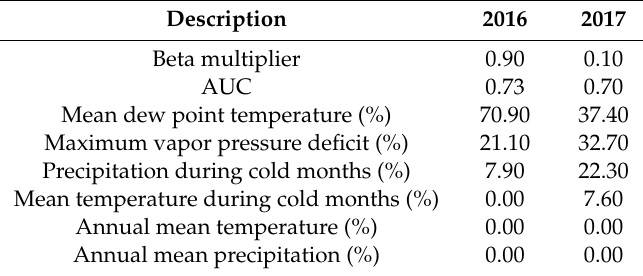
Table 4. Model regularization (beta multiplier), area under curve (AUC) under receivers operating characteristic (ROC), and contribution of each variable (%) for MaxEnt models explaining the disease probability as a function of environmental